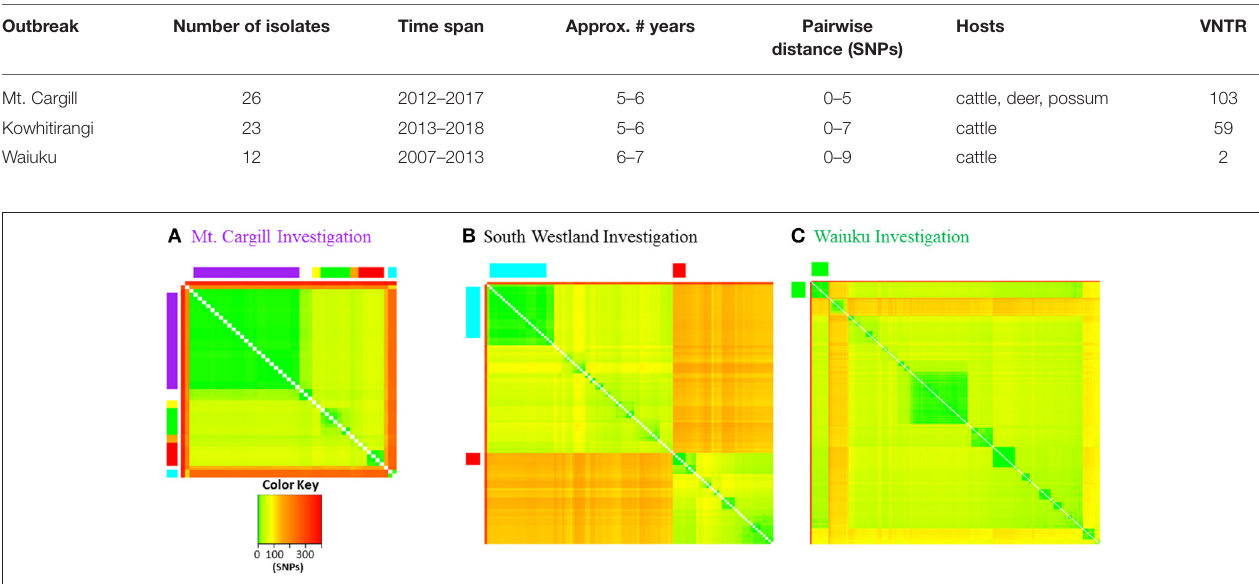
FIGURE 8 | Pairwise genetic distance heat maps . Distance in SNPs between pairs of isolates is illustrated by the different colors as indicated in the color key. (A) Mt. Cargill outbreak isolates are in the same order as in the Phylogram in Figure 3 and colors along the outside of the plot correspond to those in the Phylogram and also to those in the more detailed distance plots in Supplementary File 6 . (B) VNTR53 and VNTR59 isolates. Close relatives of South Westland breakdown type 1 are indicated by red squares and type 2 by the blue rectangles along the outside of the plot. Isolates are in the same order as in the more detailed distance plots in Supplementary File 6 . (C) CNI branch isolates. Waiuku outbreak isolates are indicated by the green squares along the outside of the